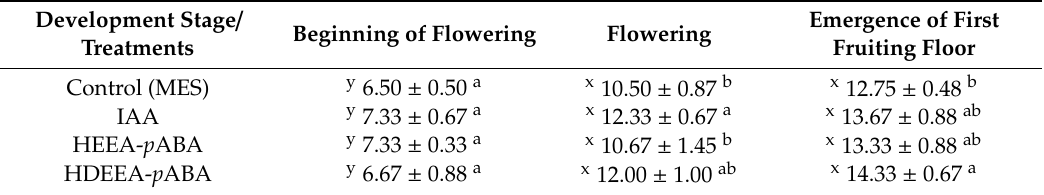
Table 6. The influence of treatments on leaves number of tomato plants (cv. Tomtim) in di ff erent stages of development.